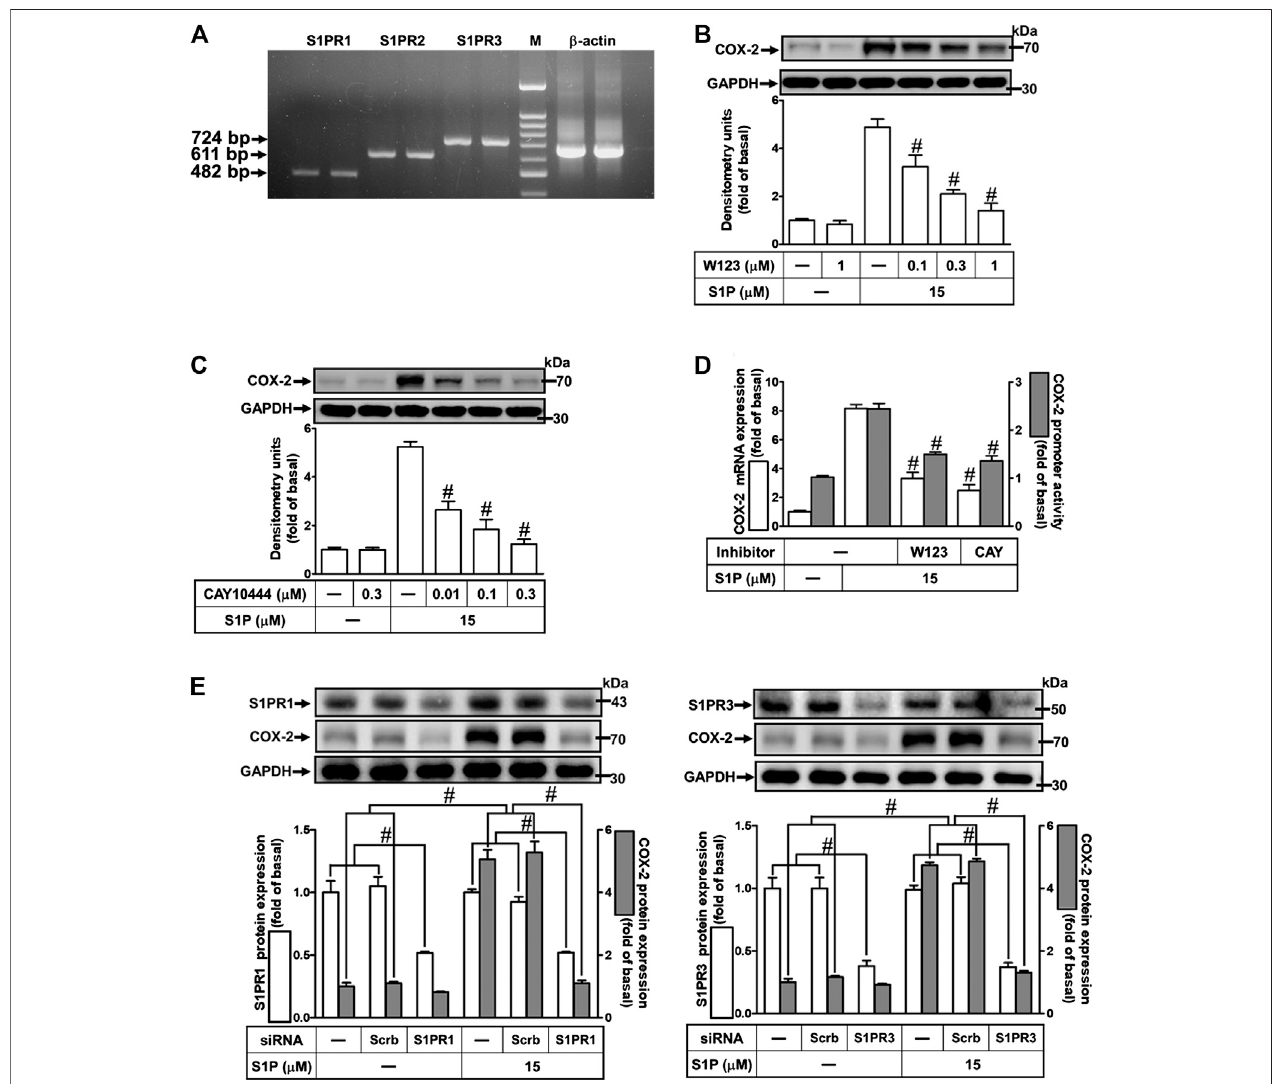
FIGURE 2 | Involvement of S1PR1 and S1PR3 in S1P-induced COX-2 expression. (A) RT-PCR analysis of S1PRs expression in HCFs. Lane 1 – 2: S1PR1; Lane 3 – 4:S1P2;Lane5 – 6:S1P3;Lane7:marker;Lane8 – 9: β -actin. (B,C) CellswerepretreatedwithW123orCAY10444for1 handthenincubatedwith15 μ MS1Pfor8 h. (D) Cells were transfected without or with COX-2 promoter-luciferase reporter gene, pretreated without or with W123 (1 μ M) or CAY10444 (0.3 μ M) for 1 h and then incubated with 15 μ M S1P for 4 h (mRNA) or 1 h (promoter). (E) Cells were transfected with siRNA for scrambled, S1PR1, or S1PR3 for 24 h and then exposed to 15 μ M S1P for 8 h. (B,C,E) The levels of COX-2, S1PR1, S1PR3, and GAPDH protein were analyzed by Western blot. (D) The levels of COX-2 mRNA and promoter activity were analyzed by real time-PCR (open bar) and promoter assay (gray bar). Data are expressed as mean ± SEM of three individual experiments (n (cid:2) 3). # p < 0.05, as compared with the cells treated with S1P